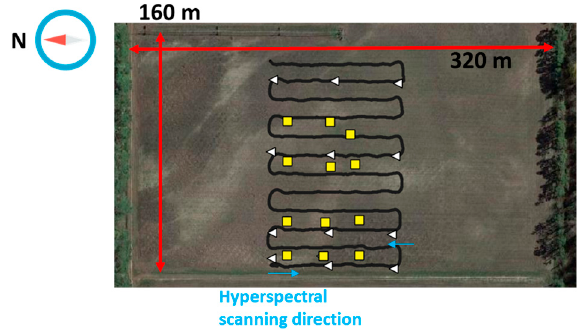
Figure 1. UAV flight paths and the position of GRPs. The black line shows the UAV flight path recorded by the UAV onboard GPS system. The white triangles mark the positions of the fence post GRPs. The yellow rectangles mark the positions of the PVC pipes. The blue arrows mark the UAV flight direction, which was the same as the scanning direction of the pushbroom camera.